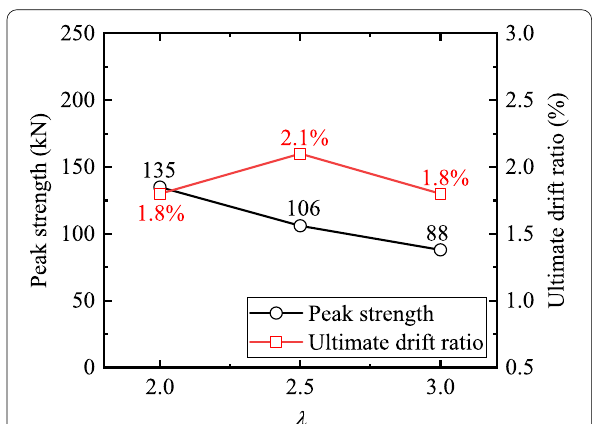
Fig. 25 Peak strength and ultimate drift ratio of specimens versus shear-to-span ratios.